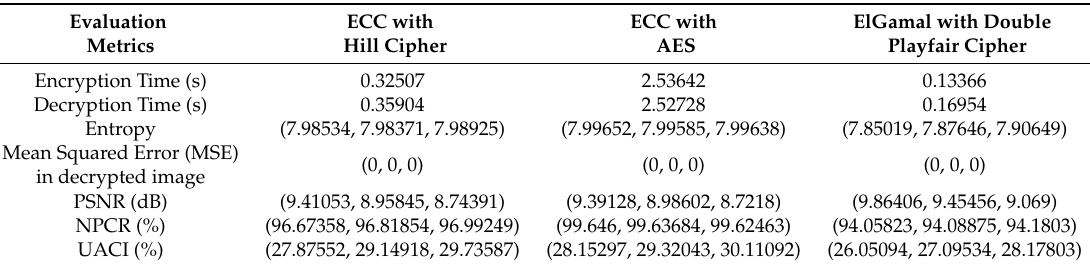
Table 5. Metric measures for Eggs